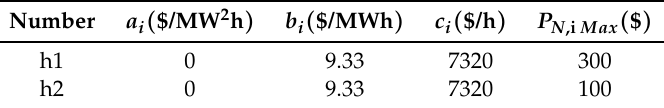
Table 2. Cost coefficients of nuclear power